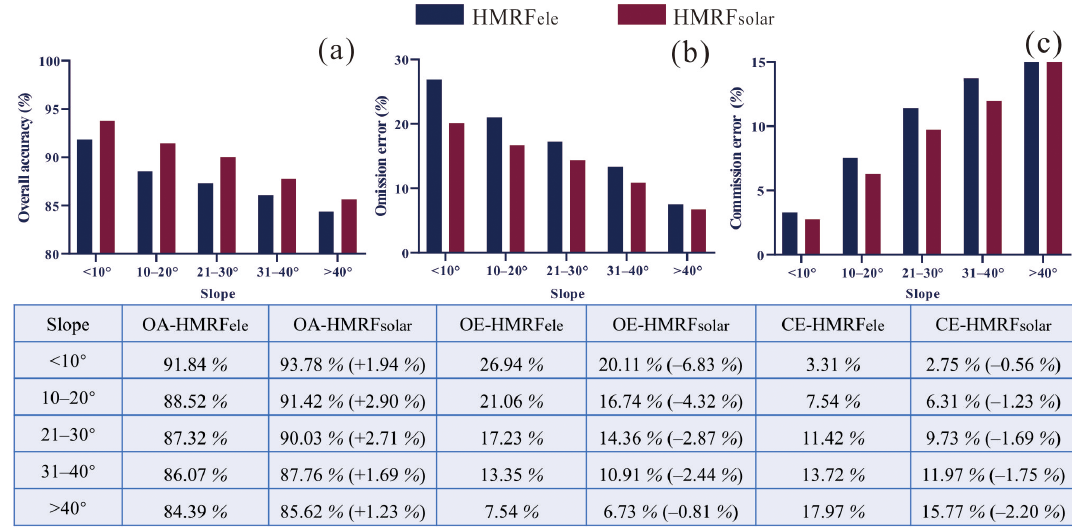
Figure 6. Effect of slope on OA (a) , OE (b) , and CE (c) of HMRF ele - and HMRF solar -based snow products from 2002–2021.